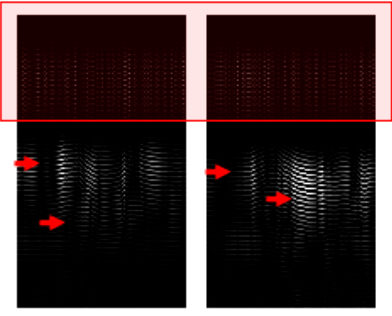
Figure 7. Similarities and differences in 2D gesture data.